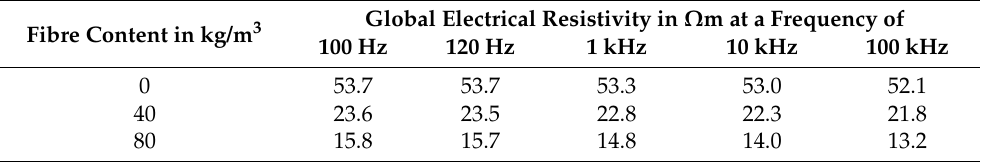
Table A44. Results of the resistivity measurements of the concrete mixture 32-60-300-00 after storage in Ca(OH) 2 for 56 days for the investigations of possible leaching effects.